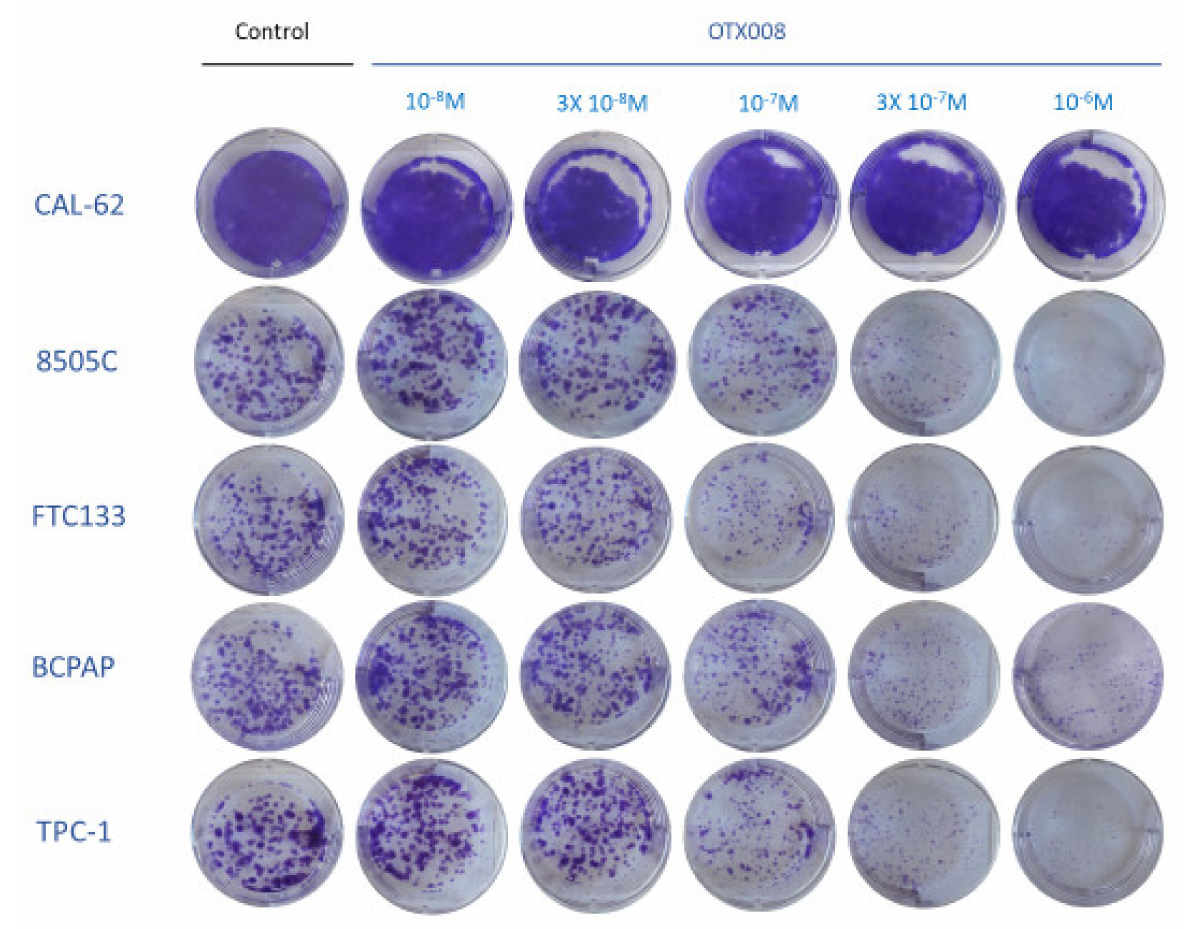
Figure 2. Evaluation of long-term effect of OTX008 on colony formation of thyroid cancer cells. Cells were treated with OTX008 concentrations ranging from 10 − 8 to 10 − 6 M for 10 days in six well plates, then fixed and stained with crystal violet solution to visualize cell